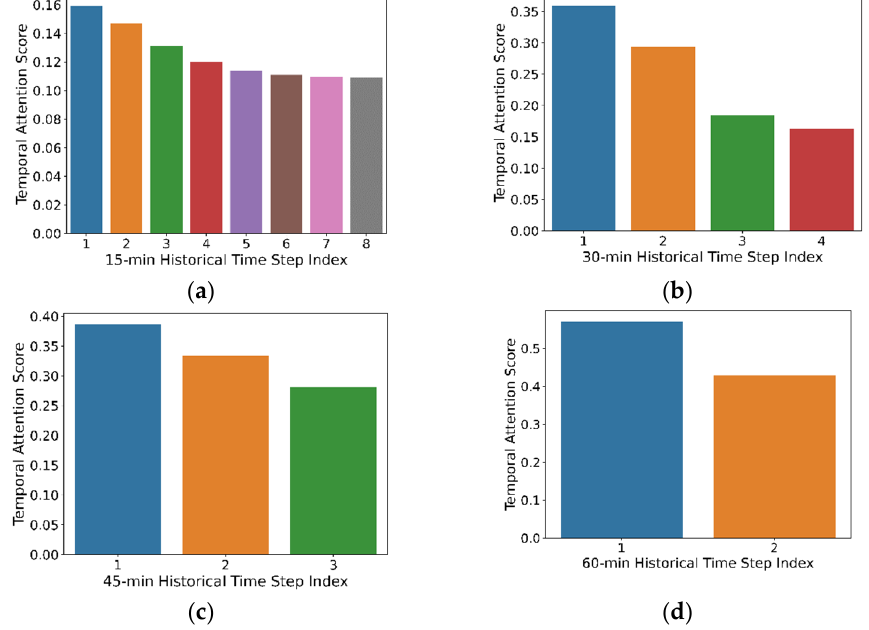
Figure 6. Temporal attention score for each time step of the different prediction horizons. ( a ) 15-min horizon; ( b ) 30-min horizon; ( c ) 45-min horizon; ( d ) 60-min